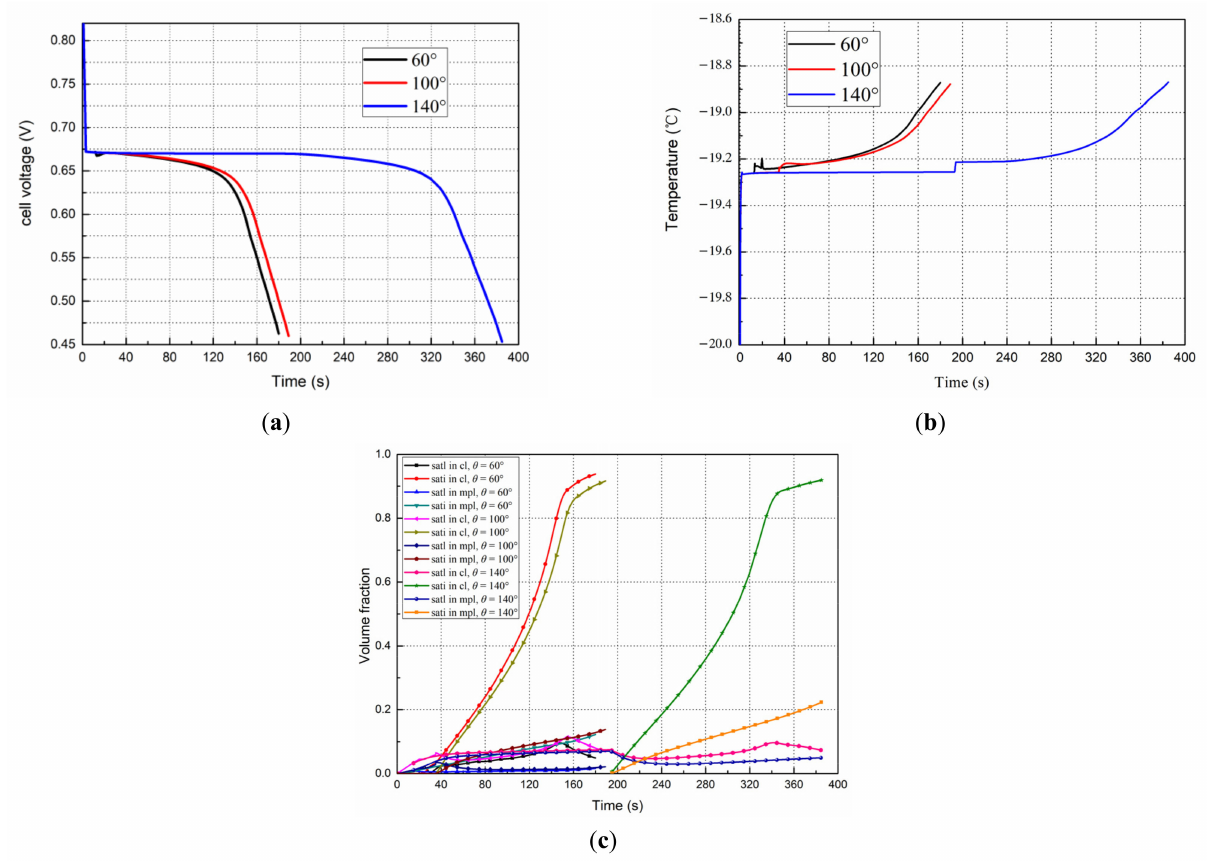
Figure 11. The effect of the contact angle in the CL on the start progress from − 20 ◦ C, 0.08 A/cm 2 . ( a ) Performance evolution ( b ) Temperature evolution ( c ) Liquid and ice saturation in the cathode CL and